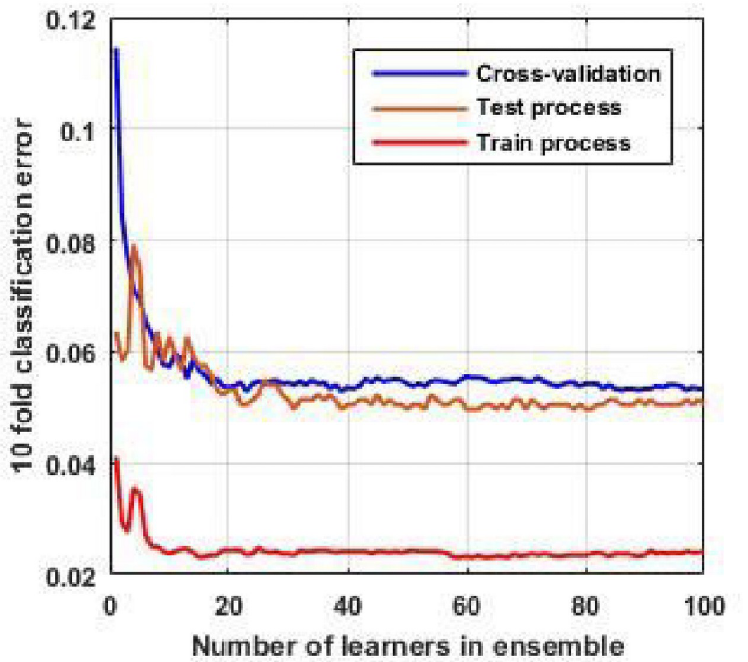
Fig 13. Error classification for KNN random subspace method. This curve indicates the performance of the algorithm.